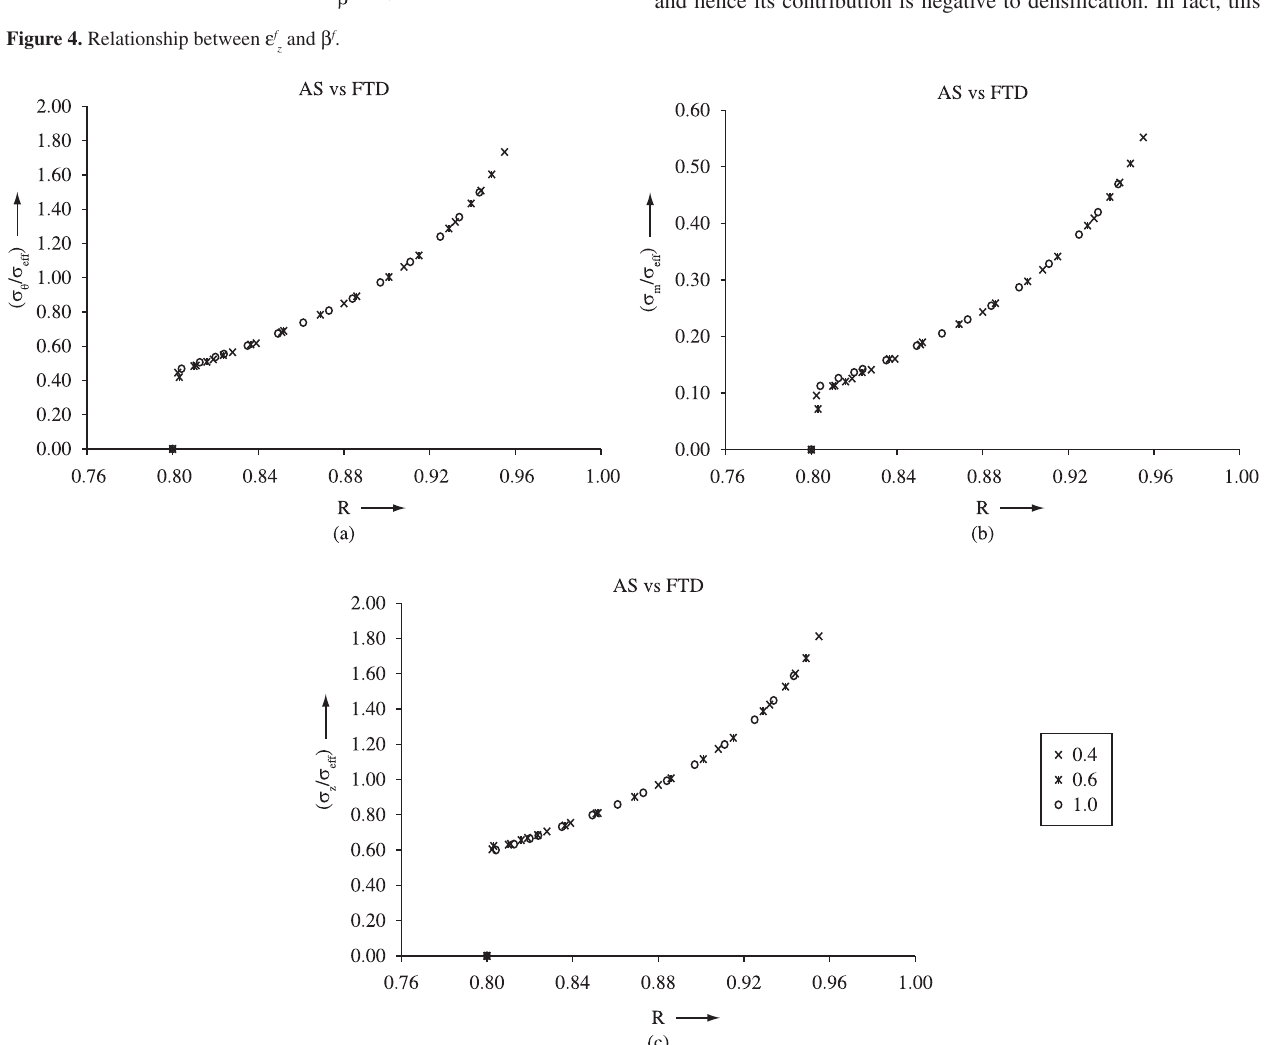
Figure 5. a) Relationship between ( σ